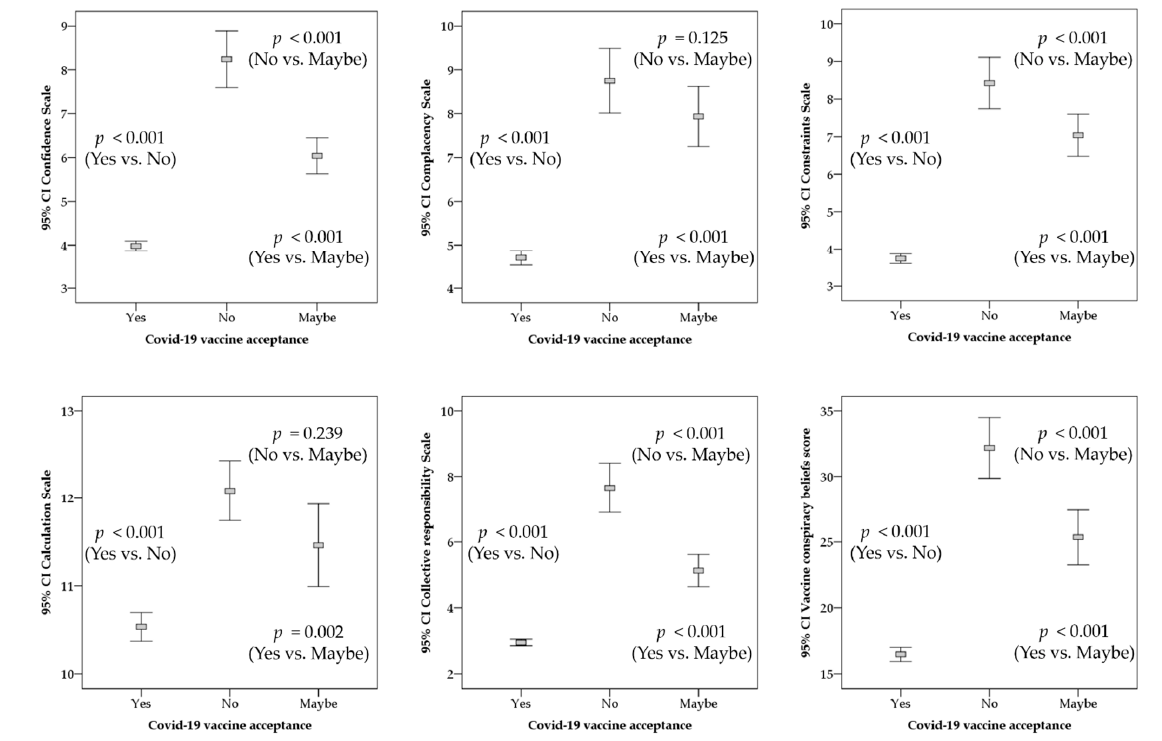
Figure 5. Analysis of COVID-19 vaccine acceptance among HCWs in Kuwait stratified based on the 5C subscales and the vaccine conspiracy belief scale (VCBS). p values are calculated based on ANOVA with Bonferroni corrections. CI: confidence interval of the mean.